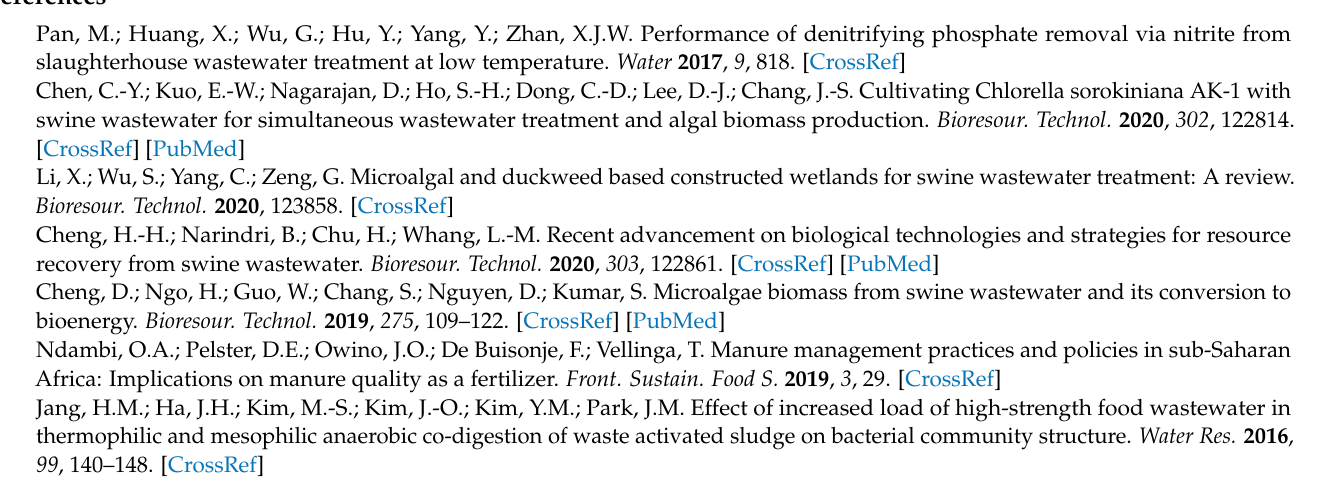
SBR system; Figure S2: Cumulative frequency curves of (a) COD, (b) NH 4+ -N, (c) TN and (d) PO 43 − -P concentrations in the effluent during the experiment; Figure S3: The concentrations of (a) proteins, (b) humic acids, and (c) polysaccharides in the soluble microbial products (SMP), loosely bound (LB-EPS) and tightly bound extracellular polymeric substances (TB-EPS) of the activated sludge during the experiment; Figure S4: Profiles of PO 43 − -P and COD during P release and uptake batch tests fed with acetate in (a) Phase I, (b) Phase II, and (c) Phase III; Figure S5: Profiles of PO 43 − -P and COD during P release and uptake batch tests fed with propionate in (a) Phase I, (b) Phase II, and (c) Phase III. Table S1: Summary of COD/P and COD/N ratios in high-strength dairy and manure wastewater [18,19,26,28,46,82]; Table S2: Component and concentrations of other trace elements in the synthetic pre-fermented high-strength wastewater; Table S3: Component and con- centrations of other trace elements in the synthetic pre-fermented high-strength wastewater [83,84]; Table S4: Average specific ammonia oxidation rate (AOR) and specific nitrite oxidation rate (NOR) in typical cycles of SBR reactor during the